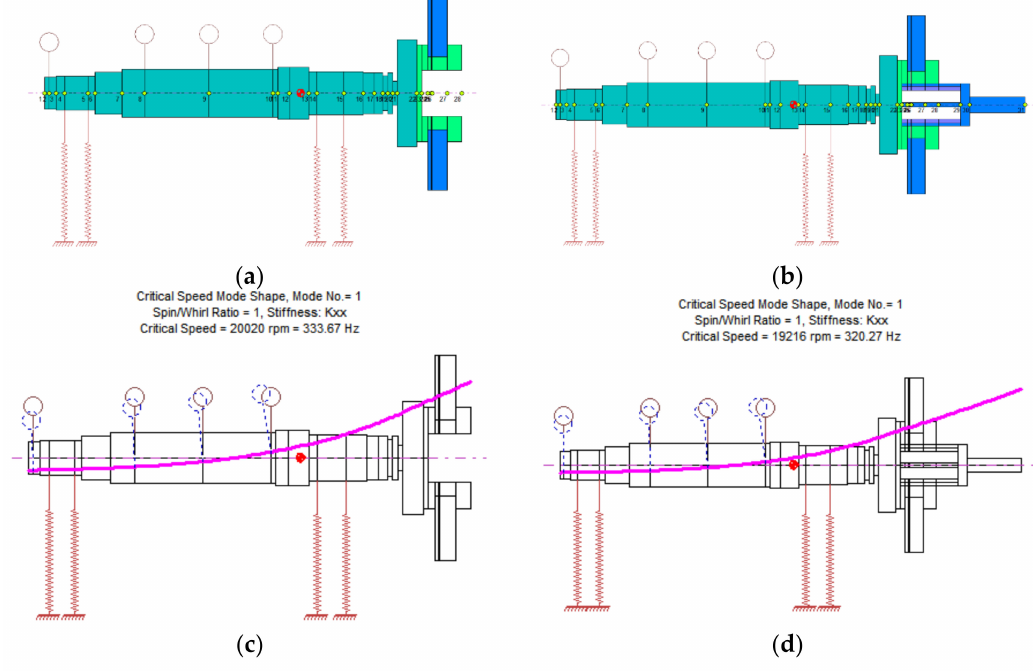
Figure 6. Rotor dynamics analysis of the rotor system: ( a ) initial rotor system mode; ( b ) rotor system model with actuator; ( c ) analysis result of initial rotor system; and ( d ) analysis result of final rotor system.